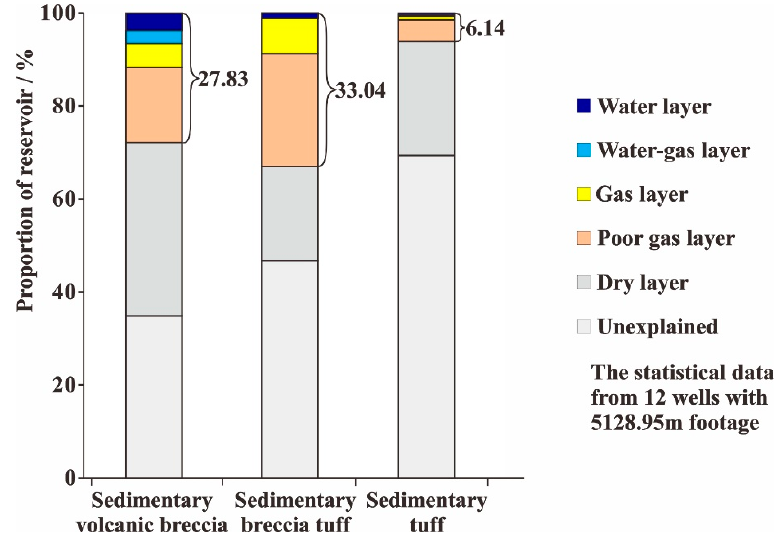
Figure 5. Proportion of sedimentary pyroclastic rocks in reservoir at K 1 y 2 , YFD. Table 1. Reservoir characteristics of sedimentary pyroclastic rocks in K 1 y 2 , YFD.